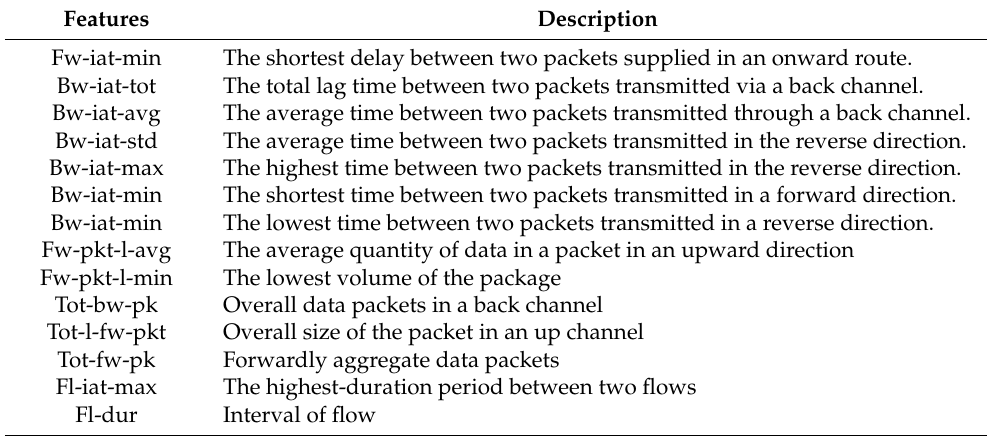
Table 1. An overview of the CICIDlS-2018 ID dataset’s extracted